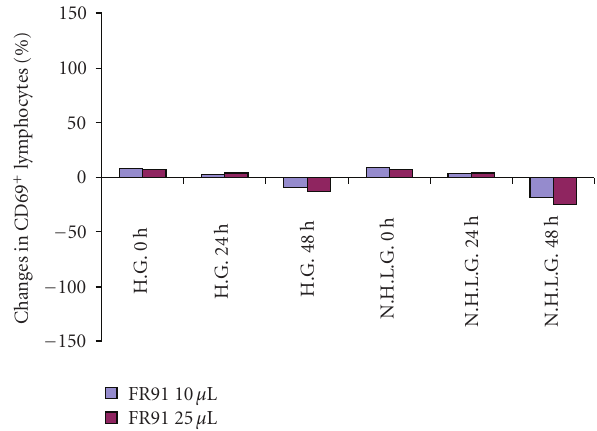
Figure 2: Mean changes in lymphocytes expressing CD69 from the healthy and NHL groups. Lymphocytes were stimulated with 10 and 25 μ L of FR-91, and results were analyzed by flow cytometry. Results are expressed as percentage of change with respect to time 0.